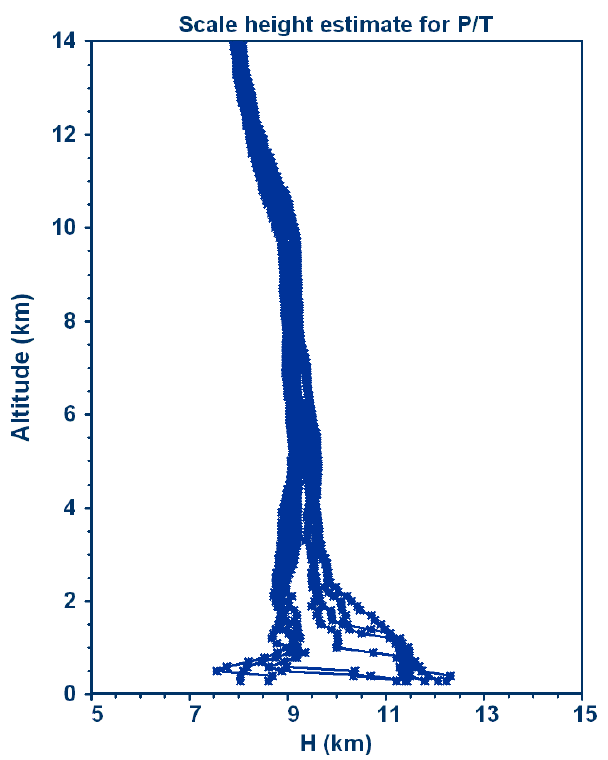
Fig. 5a. Scale height relative to the ratio P/T computed from a series of radiosoundings at CNRM/Toulouse.